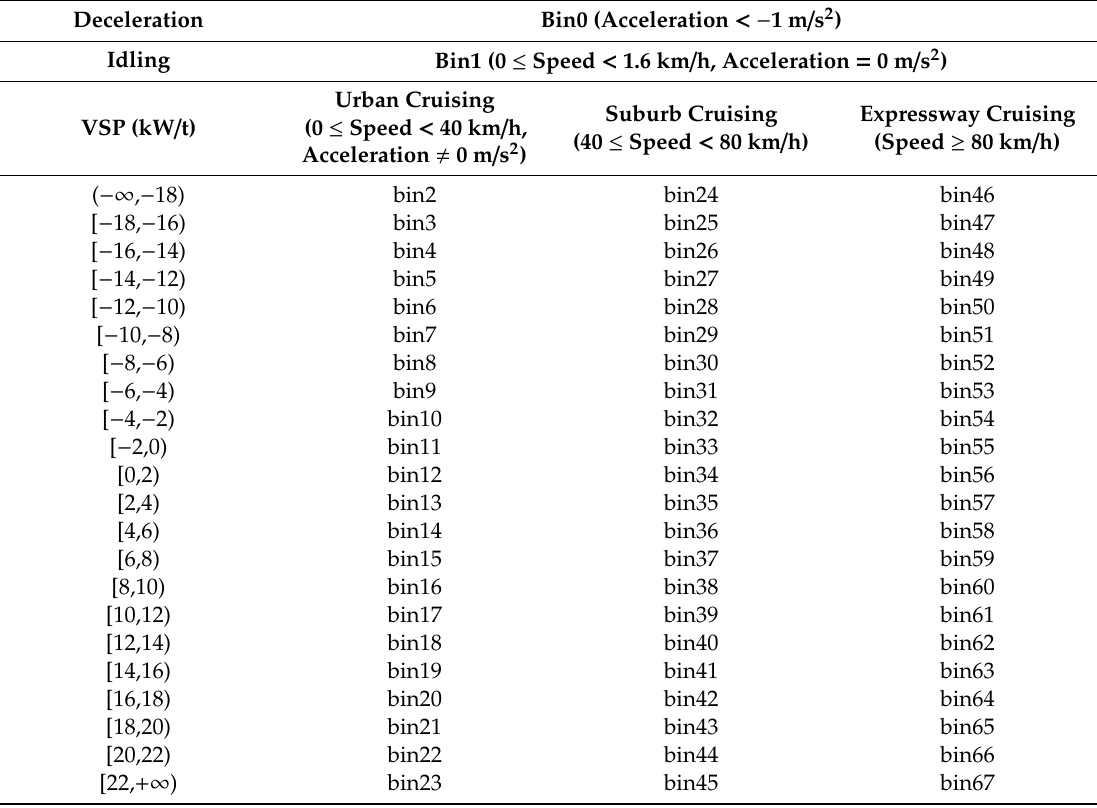
Table A4 present the interval division of 68 operation mode bins depending on the acceleration, speed, and VSP of the test vehicles.